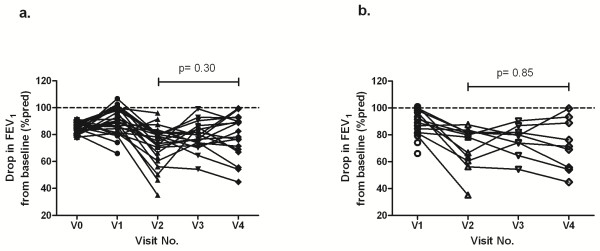
Maximal drop in FEV1during the early asthmatic response after the single-step challenges. (a). All subjects (n = 27), V0 represents the screening values. The mean drop in FEV1: V0, 15.6% ± 4.3; V1, 9.6% ± 9.9; V2, 17.5% ± 14.6; V3, 11.2% ± 10.5; V411, 2% ± 15.9. The values were not different between visits 2 and 4 (p = 0.30). (b). The 15 subjects that developed LARs. The mean drop in FEV1: V1, 11.8% ± 10.4; V2, 28.7% ± 15.3; V3, 23.8% ± 11.2; V4, 27.4% ± 18.9. The values were not different between visits 2 and 4 (p = 0.85).